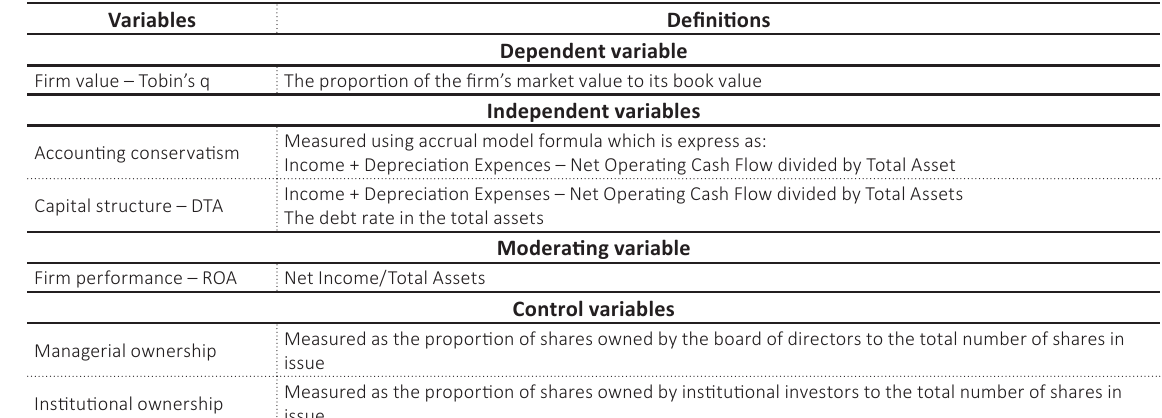
Table 1. Variable used in the